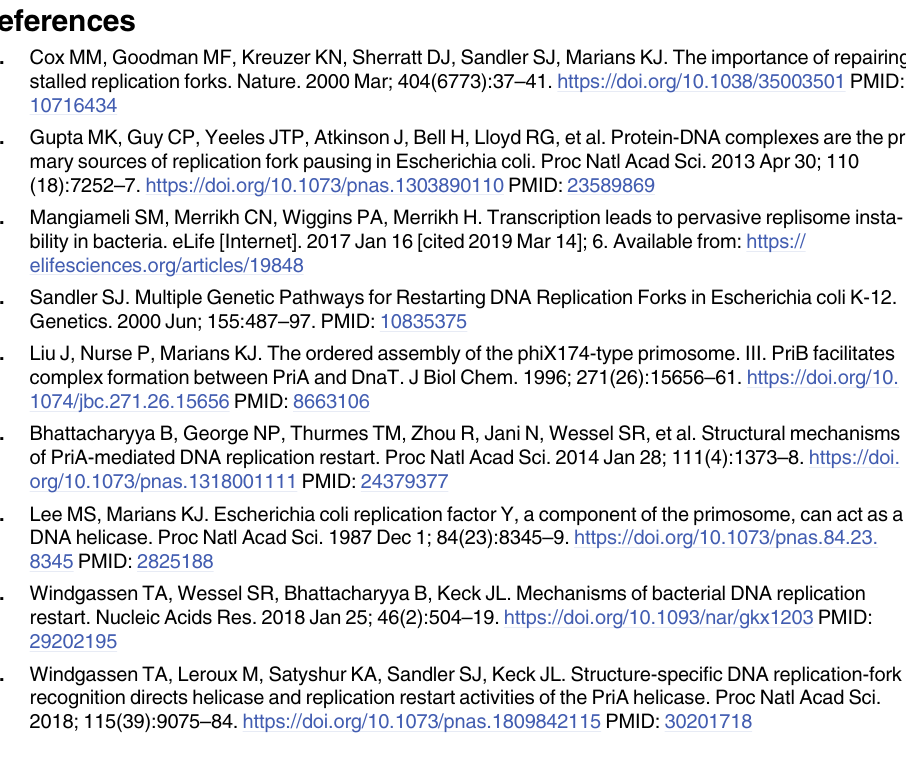
S1 Raw images. Uncropped gel images for Figs 2–5. For gels in which only a portion was used in the respective figure, the portions that were used are boxed. Gel lanes not included in the final figures are marked with a red "X". All images were obtained using a phosphorimager. (A and B) Fig 2A. (C and D) Fig 2B. (E and F) Fig 3A. (G) Fig 3C. (H) Fig 3D. (I) Fig 4A and